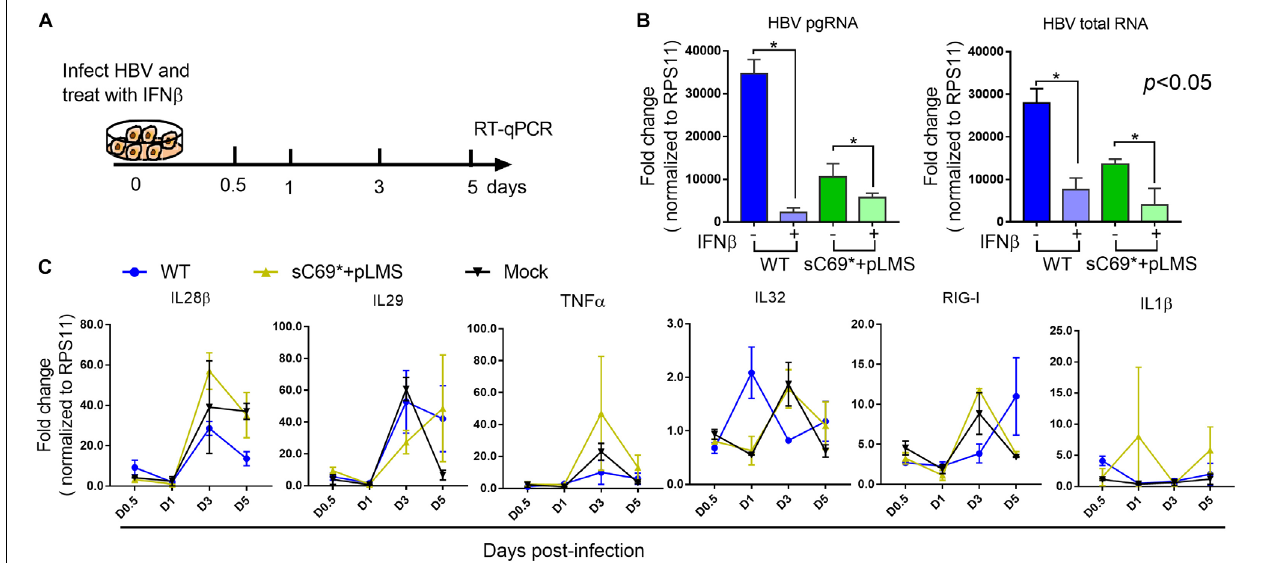
FIGURE 4 | The sC69 ∗ has no impact on IFN β induction of ISGs expression. (A) Schematic workflow for detecting identifying ISGs expression during HBV and sC69 ∗ + pLMS infection with IFN β treatment. The HepG2-NTCP cells were infected by viruses of WT or sC69 ∗ + pLMS and treated with 500 U/ml of IFN β during the infection. (B) HBV pgRNA and HBV total RNA were detected from cells 5 days post-infection. (C) Relative expression of innate immune response related genes in HepG2-NTCP cells with IFN β treatment during the infection. Data from three biological replicates are shown as means ± s.d. Statistical analysis was performed by a Student’s t -test ∗ p <